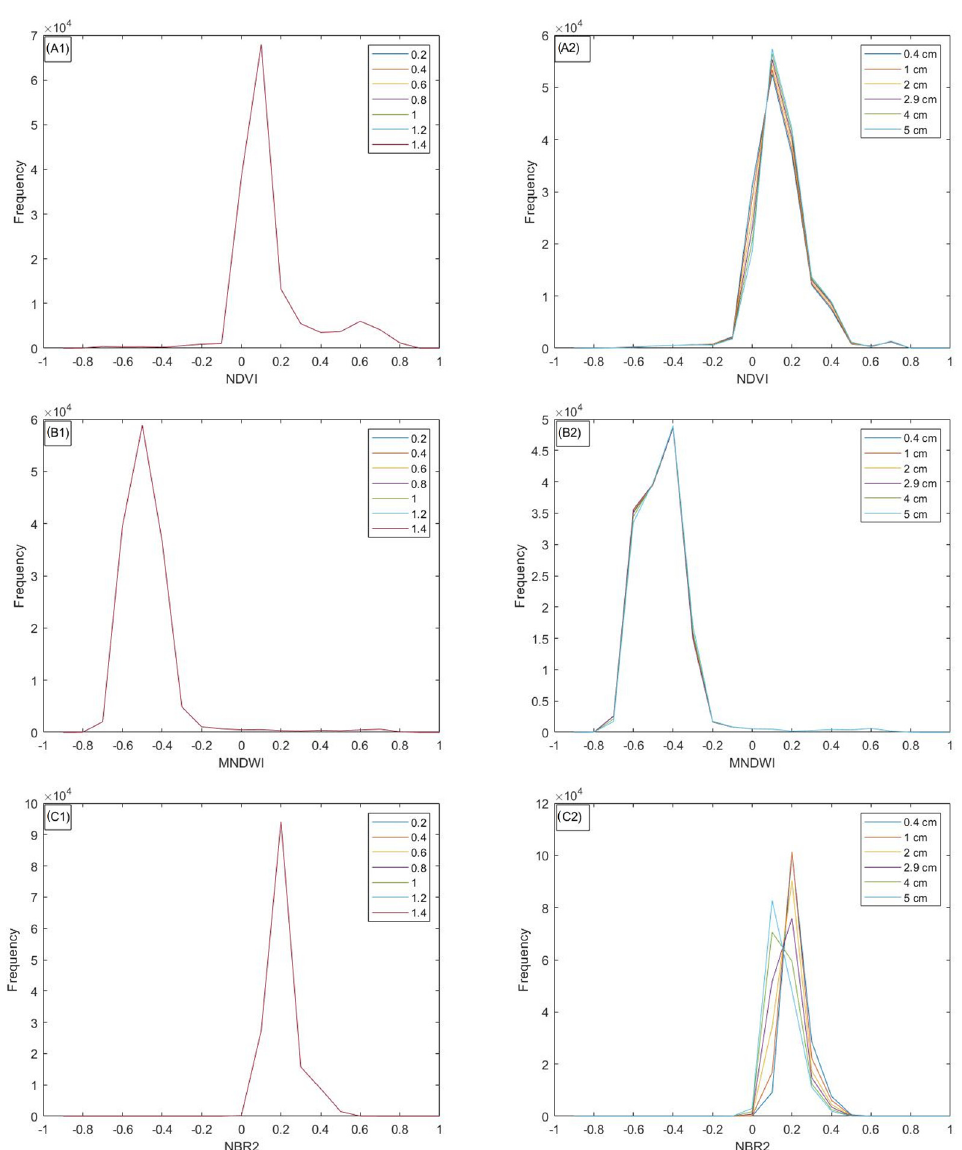
Figure 5. Histograms of NDVI (overall the area) obtained from the Hyperion images corrected with several ( A1 ) AOD and ( A2 ) WV; Histograms of MNDWI (overall the area) obtained from the Hyperion images corrected with several ( B1 ) AOD and ( B2 ) WV; Histograms of NBR2 (overall the area) obtained from the Hyperion images corrected with several ( C1 ) AOD and ( C2 ) WV.